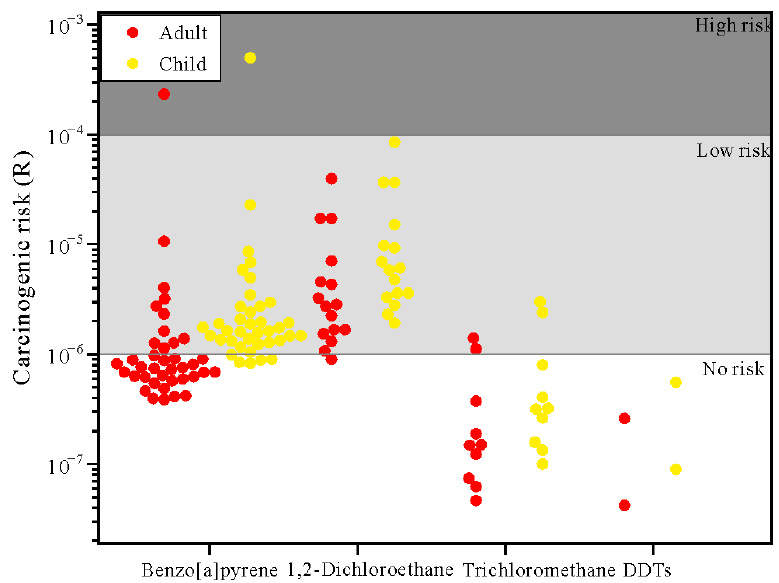
Figure 8. Health risk of PCOPs in groundwater.